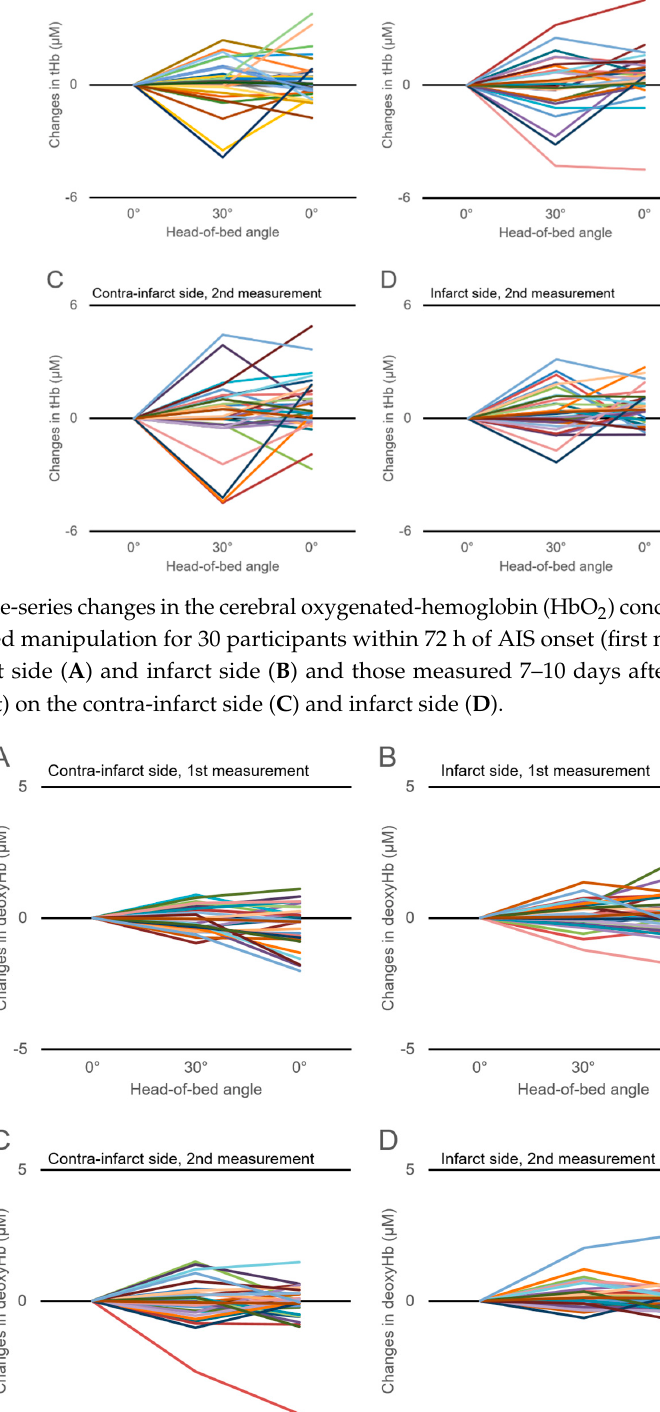
Figure 3. Time-series changes in the cerebral deoxygenated-hemoglobin (deoxyHb) concentration in response to head-of-bed manipulation for 30 participants within 72 h of AIS onset (first measurement) on the contra-infarct side ( A ) and infarct side ( B ) and those measured 7–10 days after onset of AIS (second measurement) on the contra-infarct side ( C ) and infarct side ( D ).